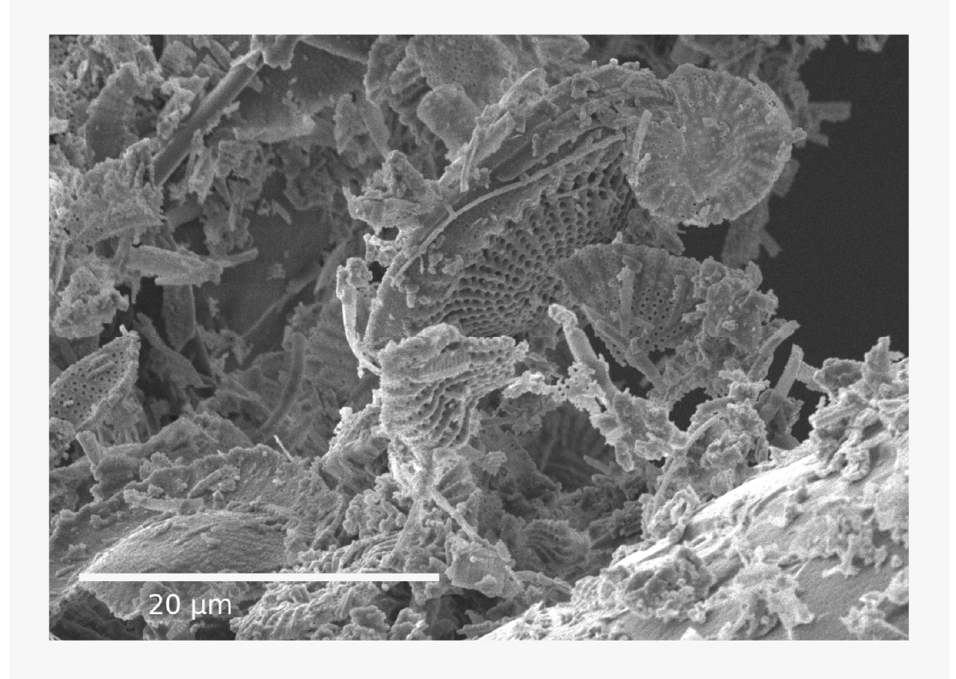
Figure 1. Scanning electron microscopy of Celite 610.